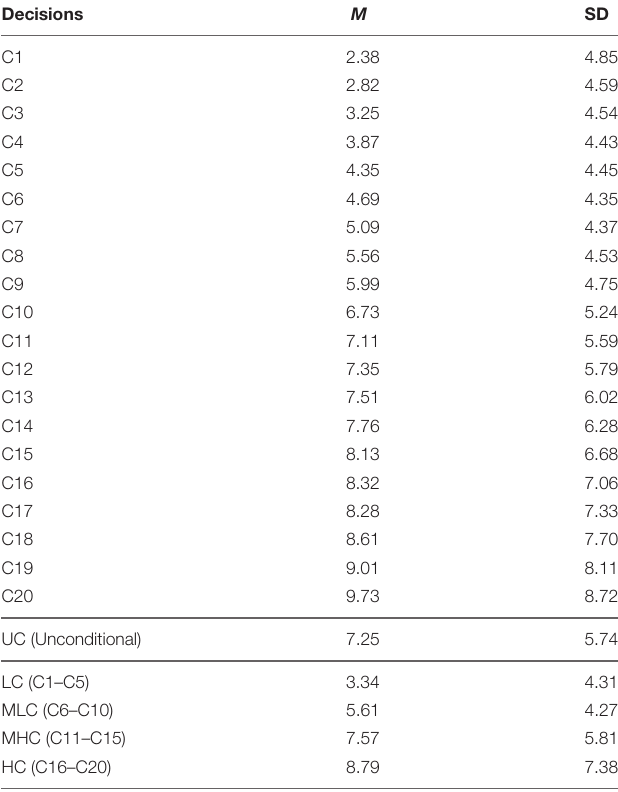
TABLE 1 | Mean and SD of game decisions in Study 1.